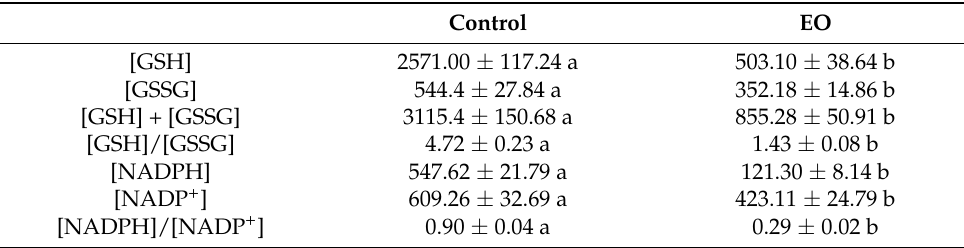
Table 2. Concentrations of GSH, GSSG, NADPH, and NADP + in HepG2 cells incubated with erythrodiol (EO) at IC50 concentration for 24 h.